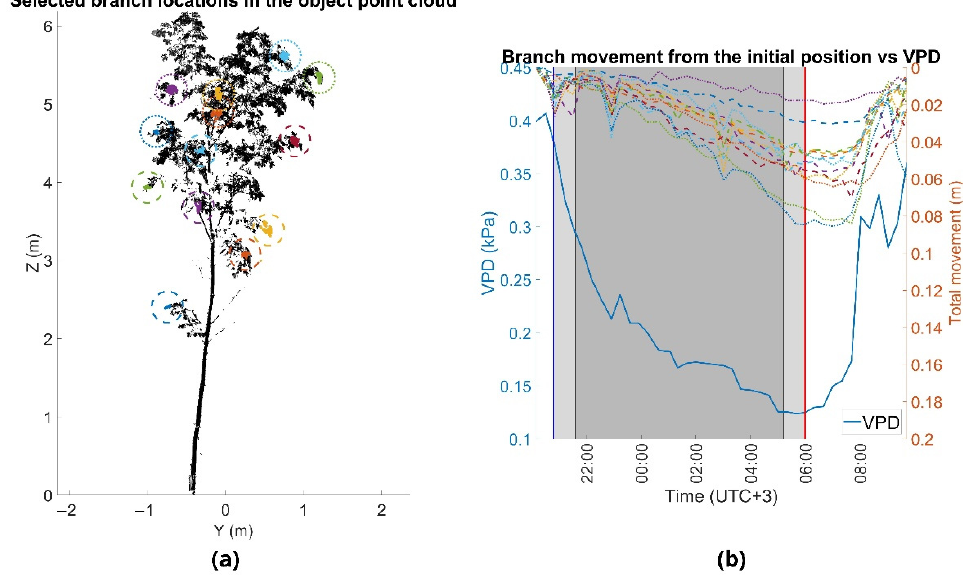
Figure 4. ( a ) Point cloud of the small Norway maple ( Norway maple L.) in August 2016. Movements were analyzed by detecting the same cluster of points from each time point. Horizontal axis shows the distance of the tree width with respect to the point cloud mean and the vertical axis shows the tree height. Point sizes in the colored clusters are emphasized for visual clarity. ( b ) Overnight branch movement during monitoring period. Branch movements are marked with the dashed and dotted lines (right y ‐ axis) and the vapor ‐ pressure deficit (VPD) with the solid blue line (left y ‐ axis). The times of sunset and sunrise are marked with the blue and red vertical lines, at 8:40 p.m. and 6:00 a.m., respectively ( y ‐ axis). Civil twilight time is marked with the light gray area, and time of nautical and astronomical twilight with the dark gray area.